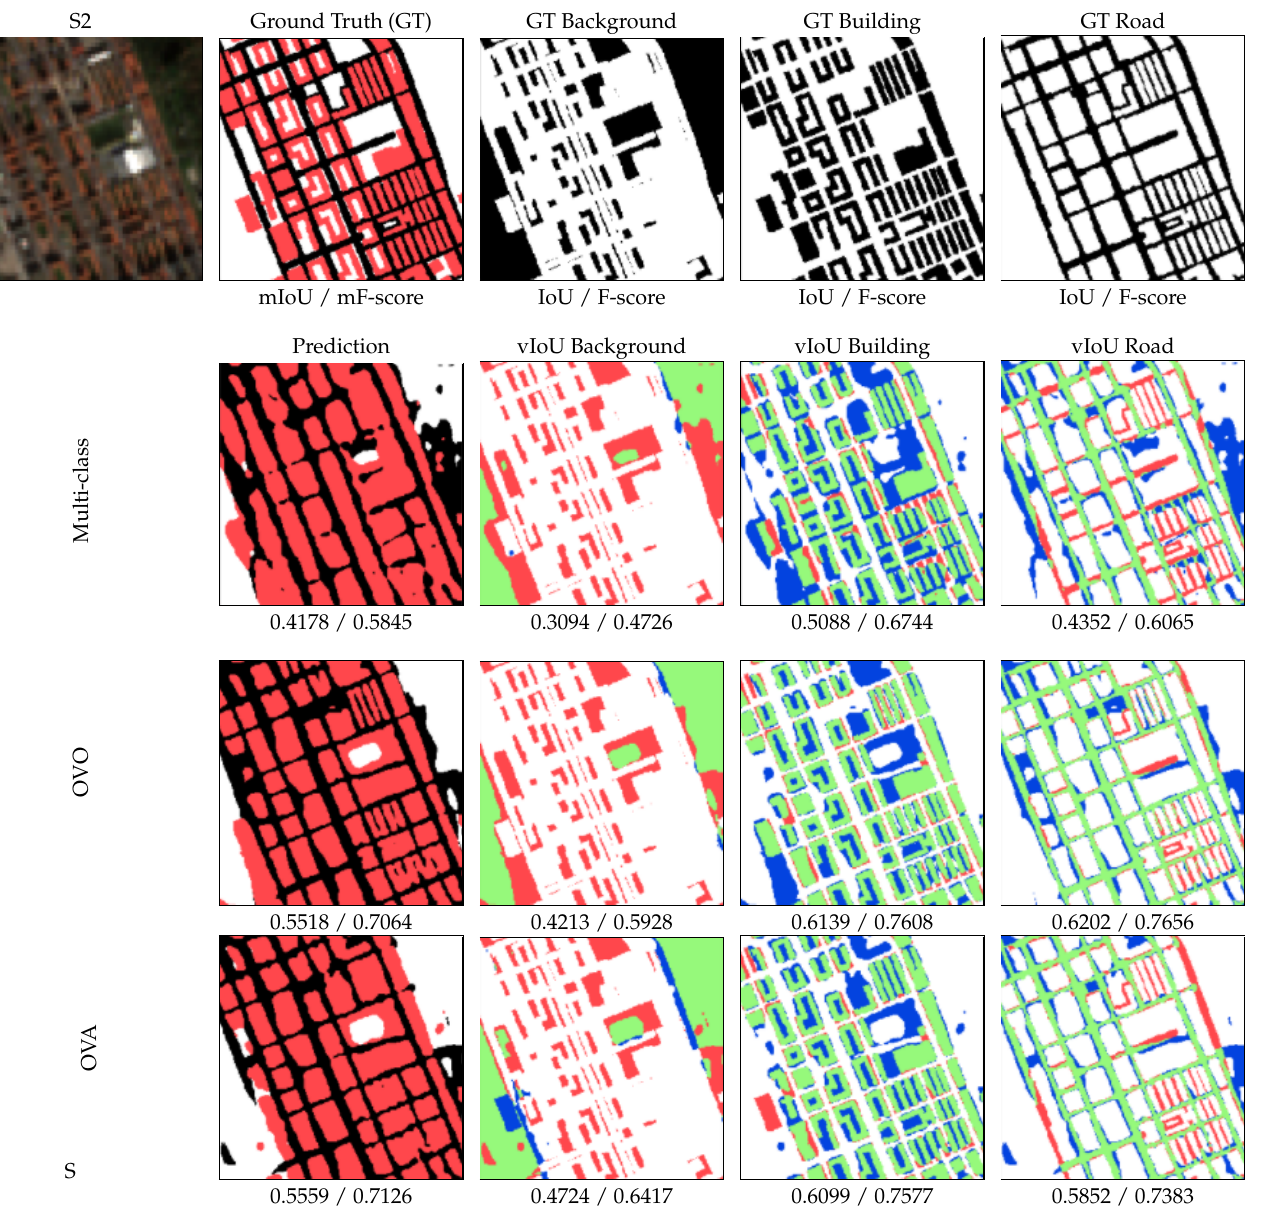
Figure 7. Qualitative results for the benefits of using decomposition strategies. Visual comparison of the results obtained with the direct multi-class approach vs. OVA and OVO binary decomposition strategies for a zone taken from Pamplona city in the test set. TP are presented in green, FP in blue, FN in red and TN in